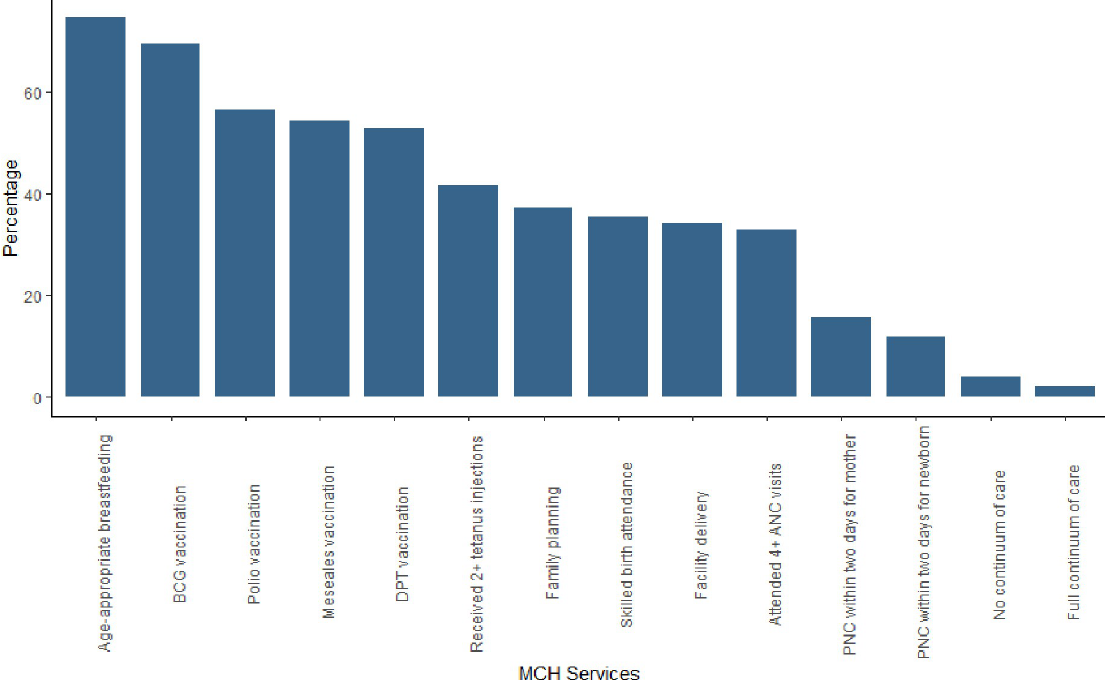
Fig 1. Components of the continuum of care (weighted n =